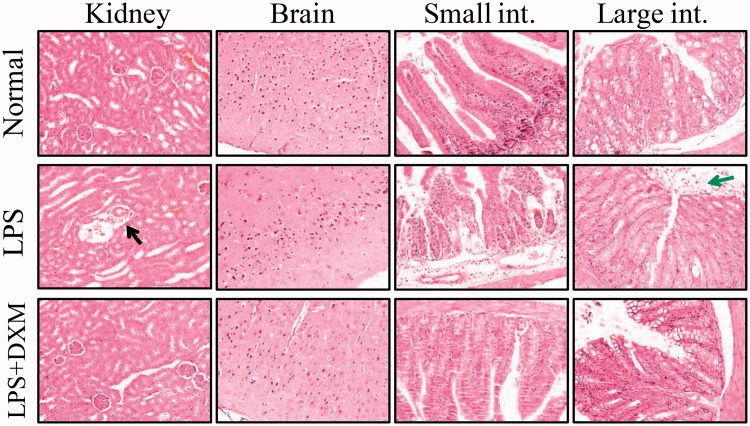
Morphology of the kidney, brain, small intestine (small int.) and large intestine (large int.) after intravenous injection of LPS (200× amplification). DXM: dexamethasone. Black arrow indicates neutrophil infiltration and green arrow indicates relapsed mucosa.